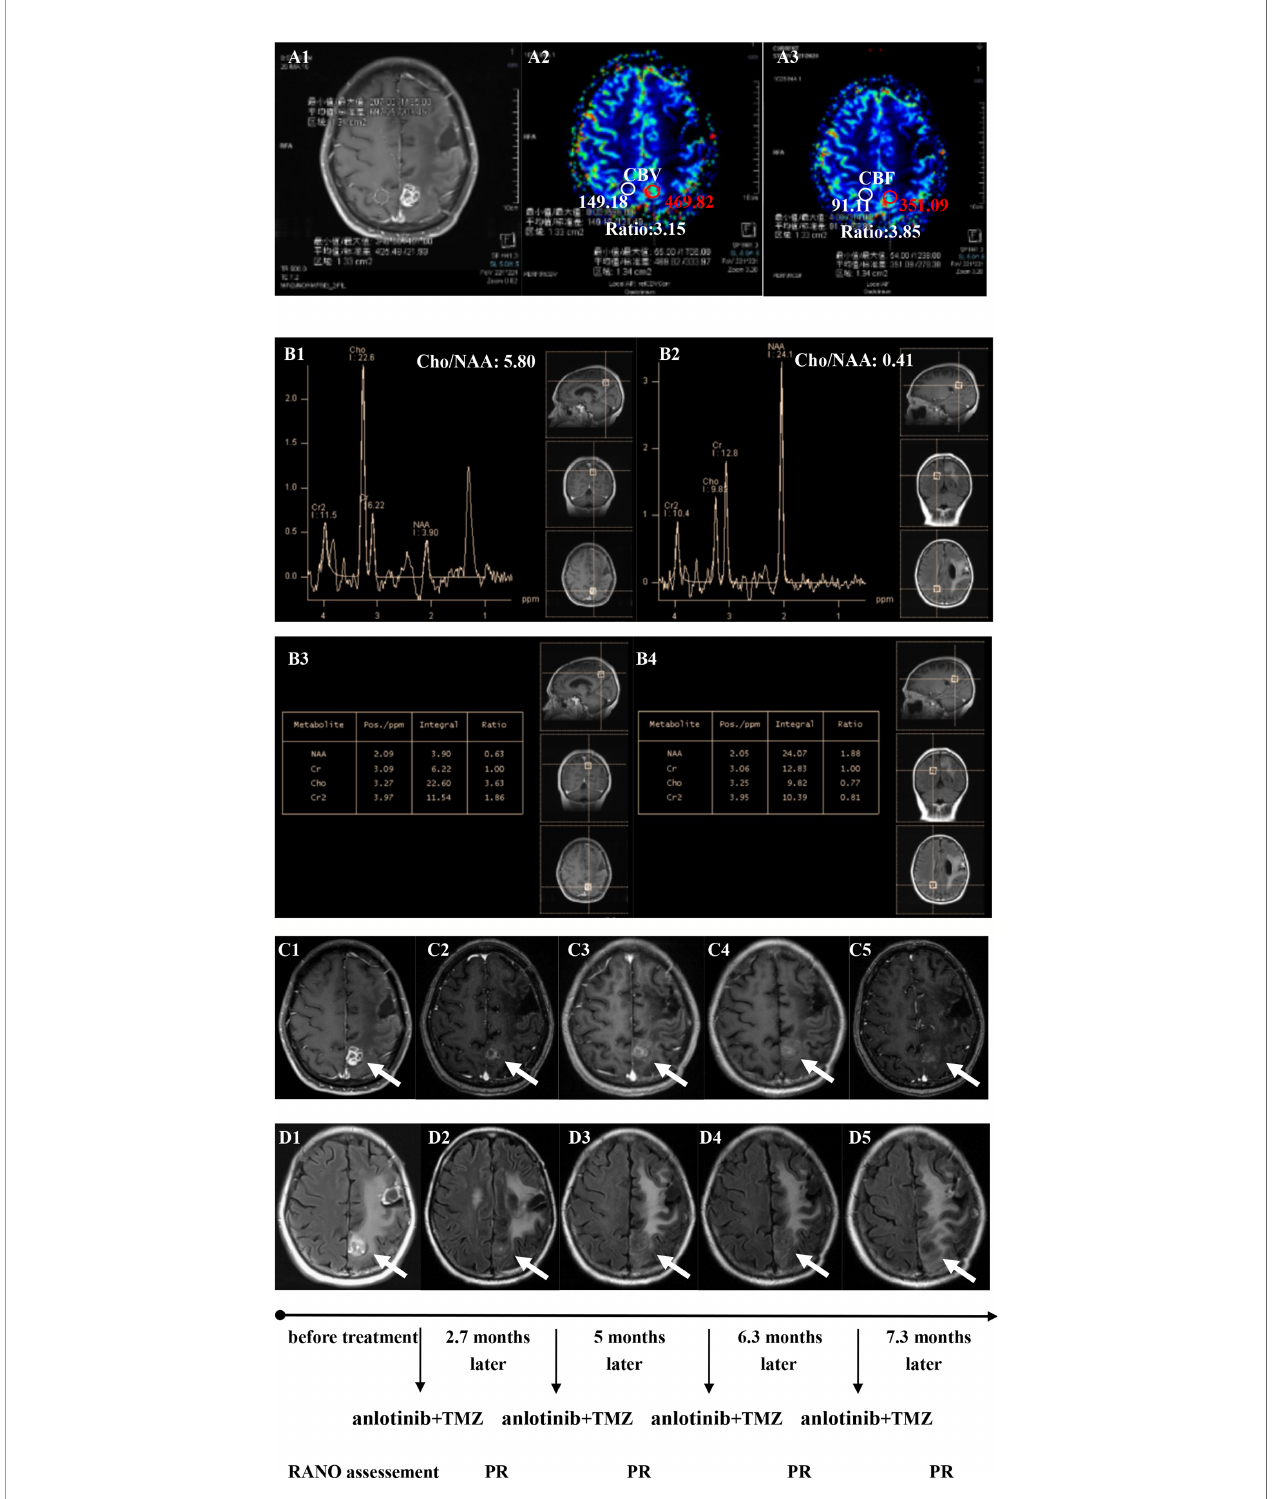
FIGURE 4 | Brain scan of patient number 17 (IDH1 − ; Recurrence occurred at a second site; The interval time between the end of CCRT and the treatment of anlotinib combined with TMZ was 2.9 months). (A1 – A3) Perfusions maps at the time of recurrence; (B1 – B4) MRS at the time of recurrence; (C1 – C5) Contrast- enhanced MRI; (D1 – D5) MRI-Flair; MRI images followed-up every 1 to 3 months before and after treatment. The arrow refers to the area of recurrence. The patient achieved partial remission after treatment and had a progression-free survival time of 8.8